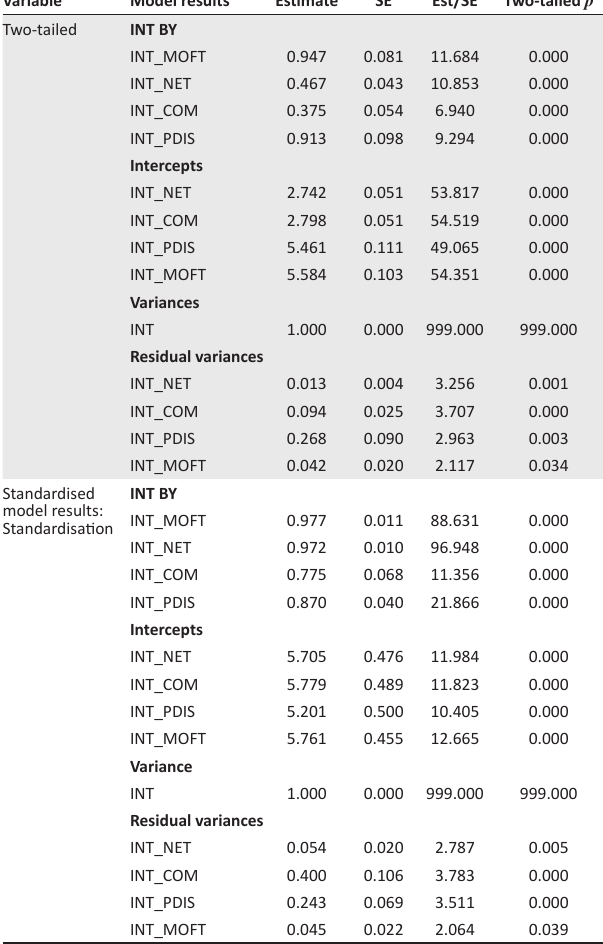
TABLE 7: Unstandardised and standardised parameter estimates of the revised Interaction dimension.